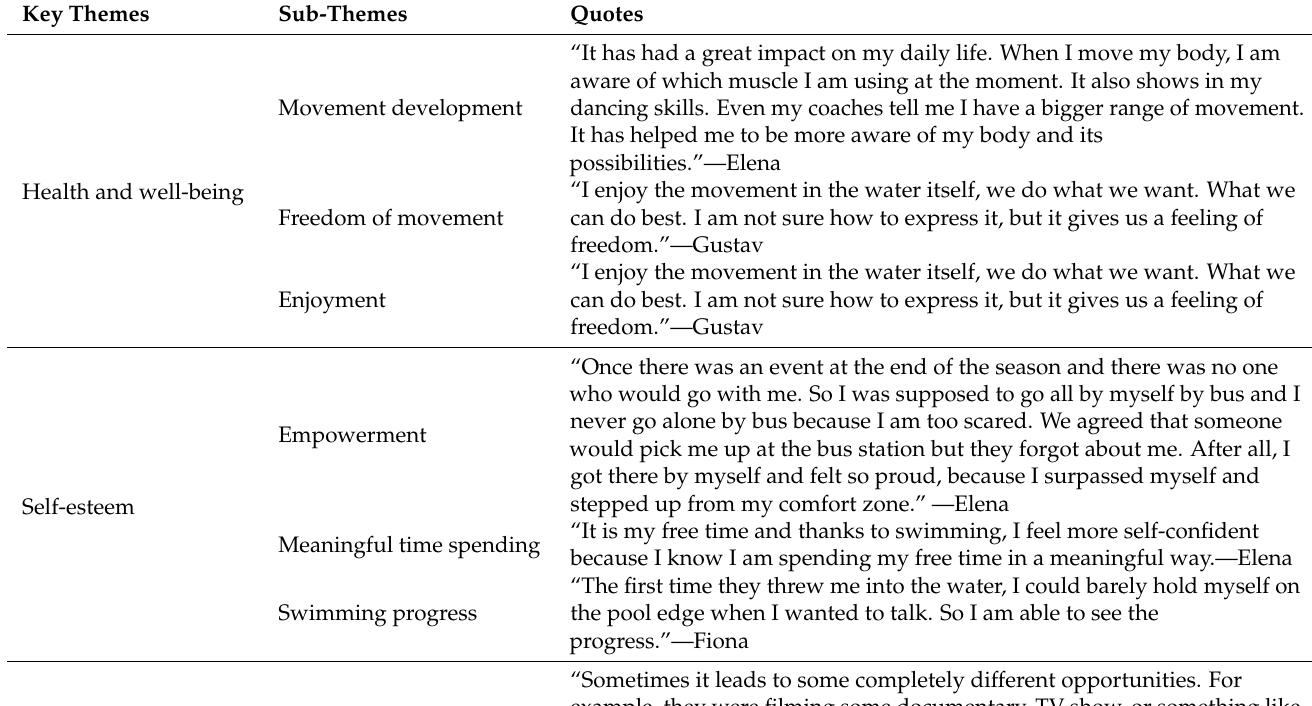
Table 3. Swimmers’ quotes according to the mentioned